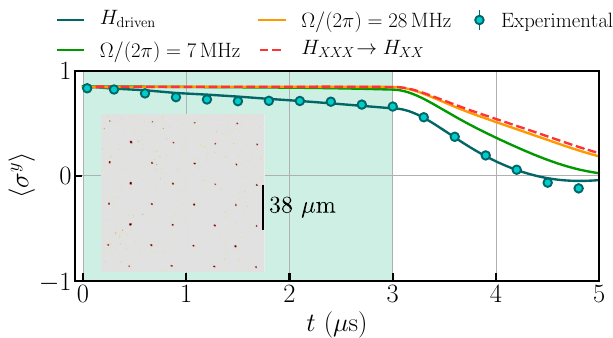
FIG. 2. The freezing of the magnetization in a 2D square array. The evolution of the total magnetization along y , (cid:6) σ y (cid:2) after ini- and evolution under H driven for the tialization in |→→ · · · →(cid:2) y first 3 μ s and H XXZ afterward. The lines show the numerical simulations based on the MACE method (see text)—all include SPAM errors: blue, H driven including the microwave imperfec- tions; green, without microwave imperfections; orange, pulse Rabi frequency (cid:4) = 2 π × 28 MHz, no microwave imperfec- tion; dashed red, evolution under H XXX , followed by H XXZ . The inset shows a fluorescence image of the 2D square array con- taining 32 atoms with an intersite distance a (cid:9) 27 μ m, leading to a nearest-neighbor interaction energy without microwaves J (cid:9) 2 π × 133 kHz and a mean interaction energy J m (cid:9) 2 π × 720